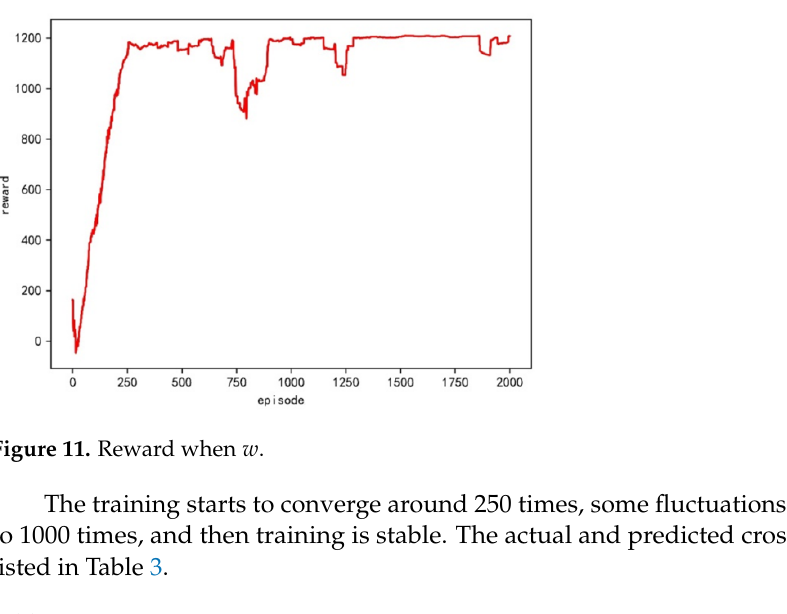
Table 3. Crossing patterns comparison.